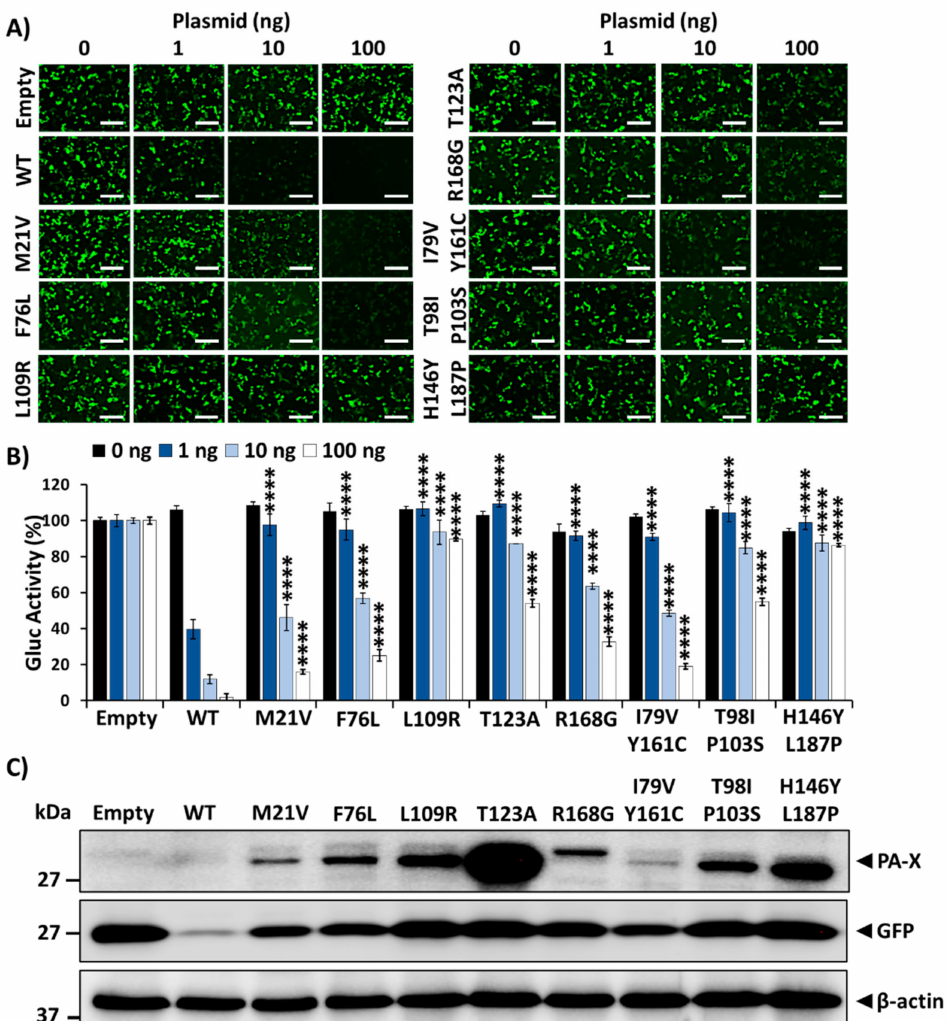
Figure 3. Effect of 1918 PA-X mutants on host gene expression inhibition: HEK293T cells were co-transfected with increasing concentrations (0, 1, 10, or 100 ng/well) of pCAGGS expression plasmids encoding the identified 1918 PA-X mutants and 250 ng of pCAGGS-Gluc and -GFP plasmids. Empty and 1918 WT PA-X pCAGGS plasmids were included as controls. At 24 h p.t., GFP was observed under a fluorescence microscope ( A ), and Gluc activity was quantified from cell culture supernatants ( B ). Gluc activity was normalized to the empty plasmid control transfected cells (100%). **** p < 0.0001; (PA-X WT versus PA-X mutants for each amount of plasmid) using one-way ANOVA and Dunnett’s test for multiple comparison correction. PA-X and GFP expression levels in cell lysates from the cells transfected with 100 ng/well of pCAGGS expression plasmids encoding the 1918 PA-X mutants were analyzed by Western blot using anti-HA or anti-GFP PAbs, respectively ( C ). β -actin was used as a loading control. Results are the means and SDs of triplicates. Data are representative of three separate experiments. Magnification 20 × , scale bar, 100 µ